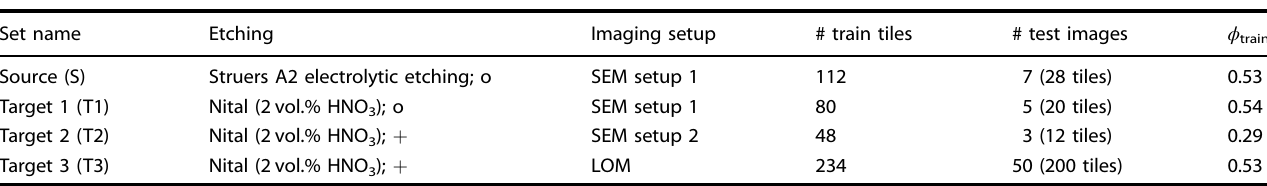
Table 6. Micrograph set